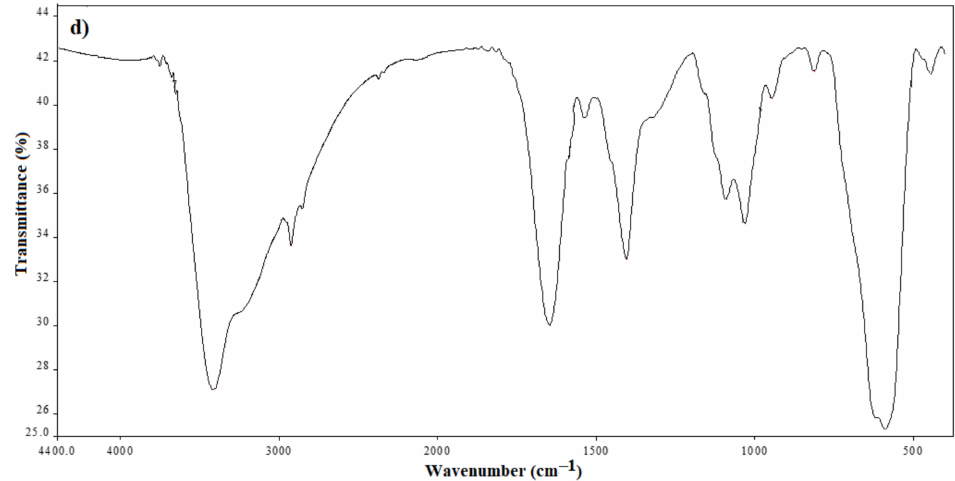
Figure 2. FTIR spectra of ( a ) DA-ALG, ( b ) OA-ALG, ( c ) OA-MNPs, and ( d ) DA-MNPs.